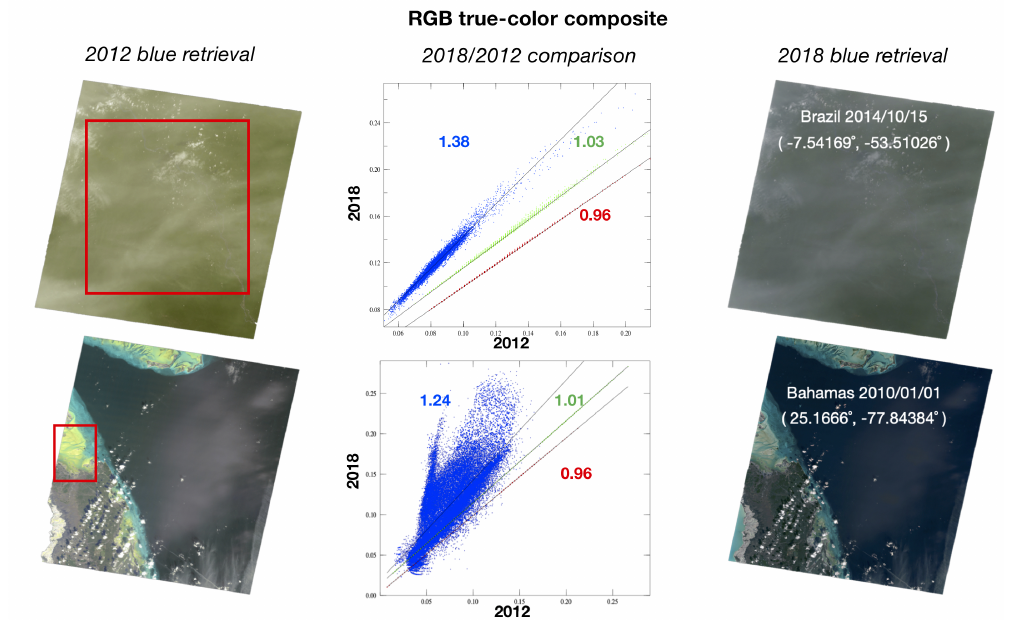
Figure 7. Comparisons of ASTER granules obtained with the blue retrieval algorithms of 2012 ( left ) and 2018 ( right ). The center panel shows the correlations between the reflectance values collected within the red boxes, obtained with the 2012 (x-axis) and 2018 (y-axis)